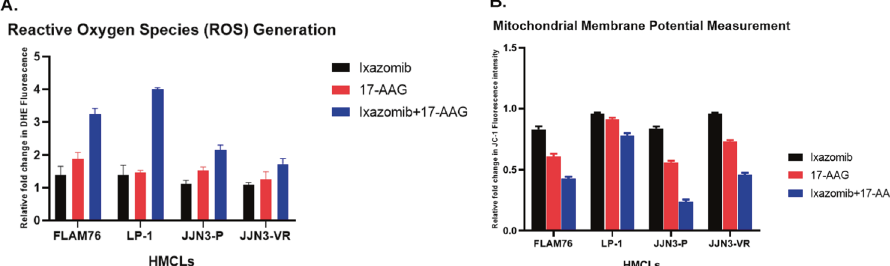
Fig. 5 17-AAG induces super-oxide levels, intracellular ROS generation, and mitochondrial membrane potential (MMP) in myeloma cell lines. A Super-oxide. Cellular superoxide anions were measured by using the fl uorescent dye DHE (Abcam), and red fl uorescence was detected by Synergy Neo2 multi-plate reader. B Mitochondrial membrane potential (MMP) was assessed using JC-1 (Abcam), a cationic carbocyanine dye that accumulates in mitochondria. The dye exists as a monomer (green fl uorescence) at low mitochondrial membrane potential and changes color from green to red in energized mitochondria. Cells were incubated with 5 μ M JC-1 dye for 15 min in the dark at 37 °C, washed twice in PBS, and then analyzed for red and green fl uorescence by Synergy Neo2 multi-plate toward an on-target effect of 17-AAG treatment leading to the anti-MM ef fi cacy. NRas mutant HMCL showed high sensitivity to 17-AAG treatment Finally, the myeloma cell lines ANBL6P, ANBL6VR, and ANBL6 NRas mutant were treated with single-agent 17-AAG, Ixa, and 17-AAG +